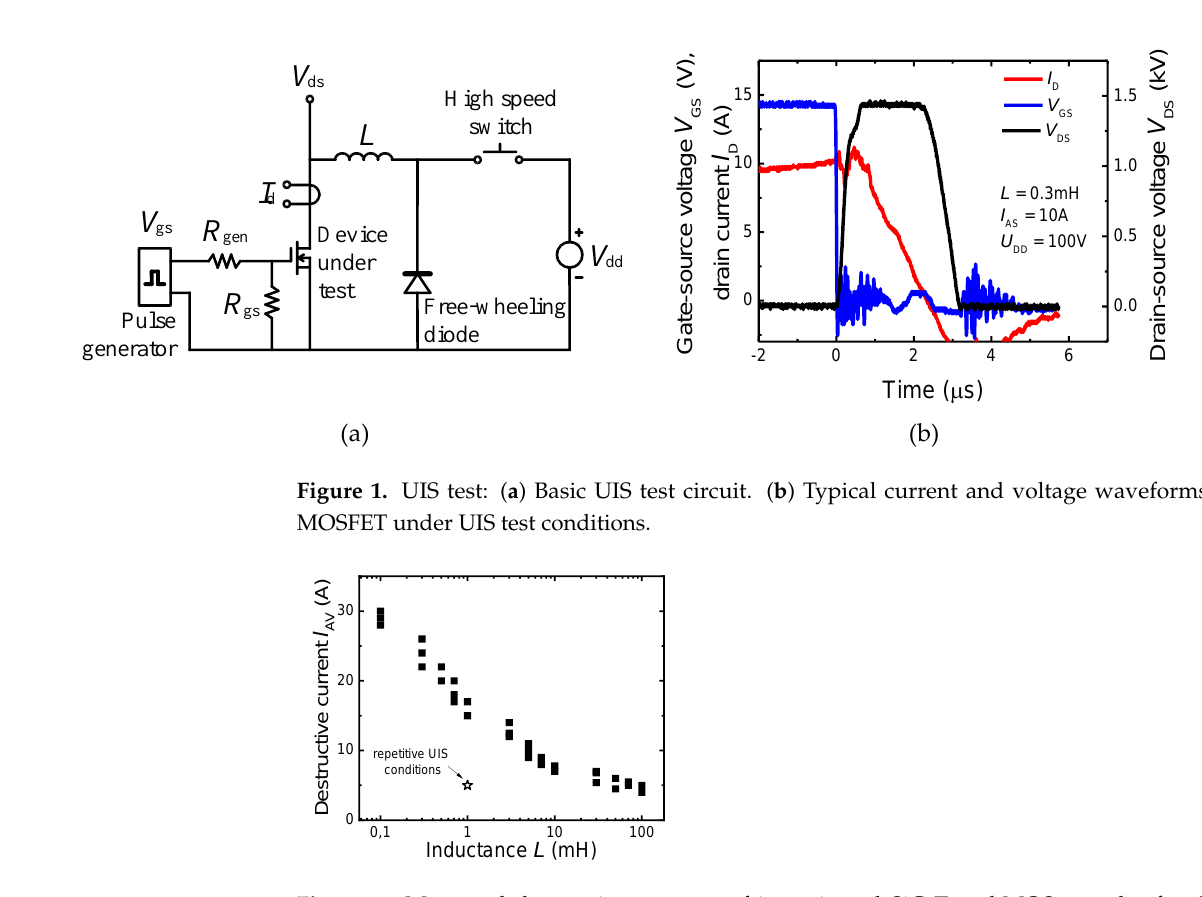
Figure 2. Measured destructive currents of investigated SiC TrenchMOS samples for different inductive loads. The star symbol represents the stress current induced during the repetitive UIS test.